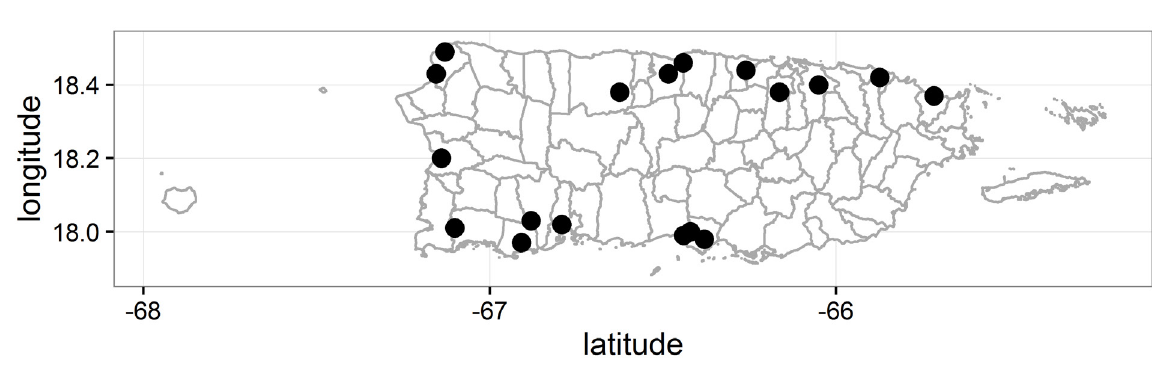
Fig. 17. Distribution map for Lasioglossum ferrerii (Baker, 1906) in Puerto